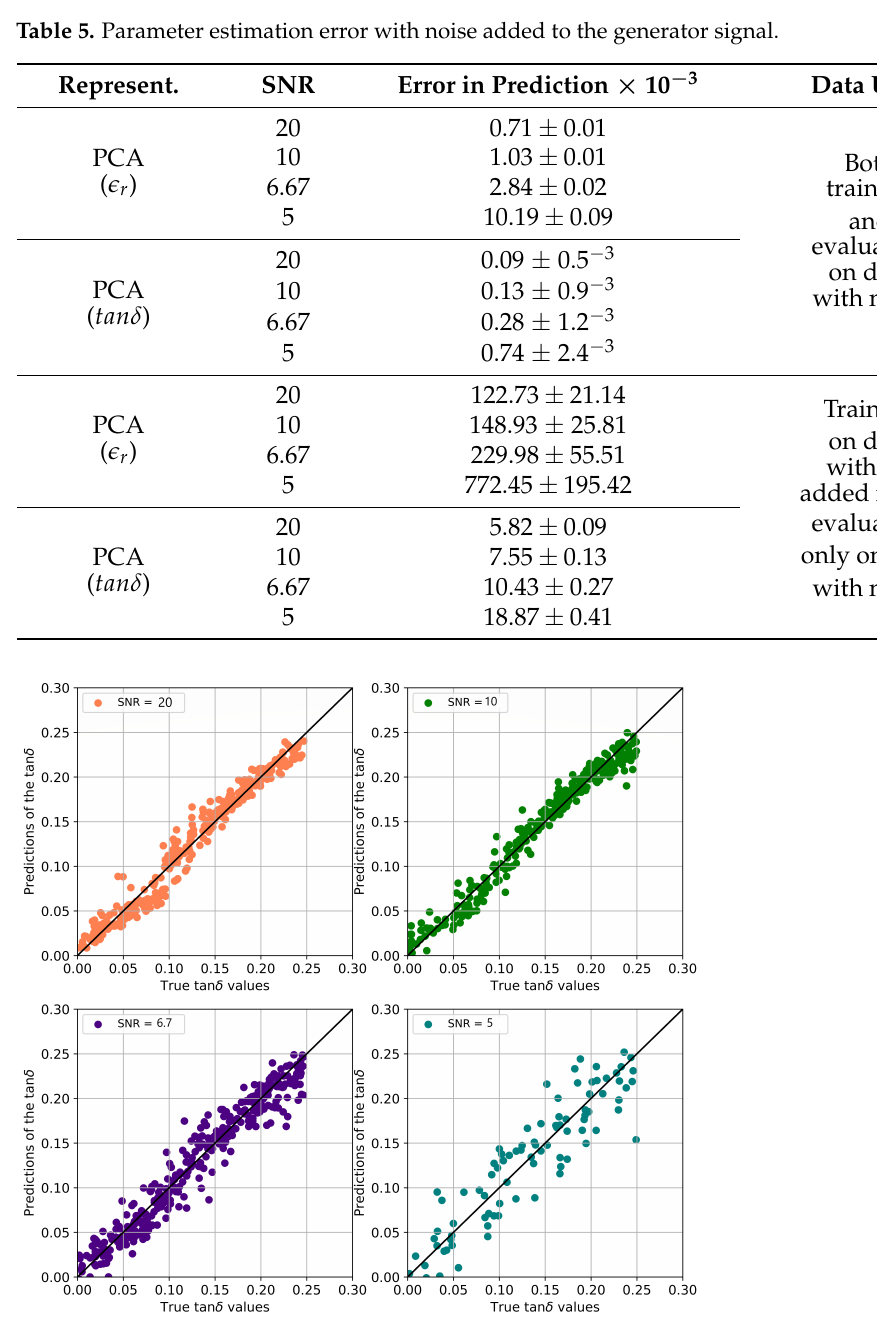
Figure 9. Dielectric loss estimation of data with different noise